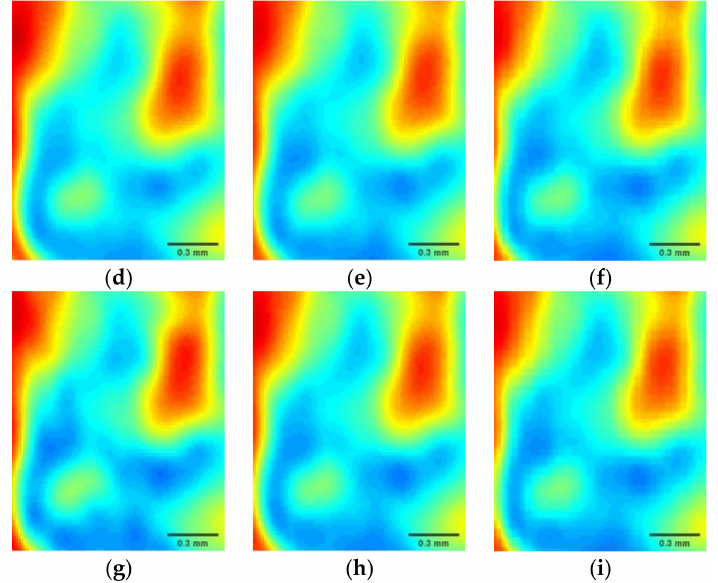
Figure 4. Reconstruction results of different methods for the wheat seed at the selected regions. ( d ) SSC at a 30% sampling rate; ( e ) DSC at a 30% sampling rate; ( f ) HSM at a 30% sampling rate; ( g ) SSC at a 40% sampling rate; ( h ) DSC at a 40% sampling rate; ( i ) HSM at a 40% sampling rate.